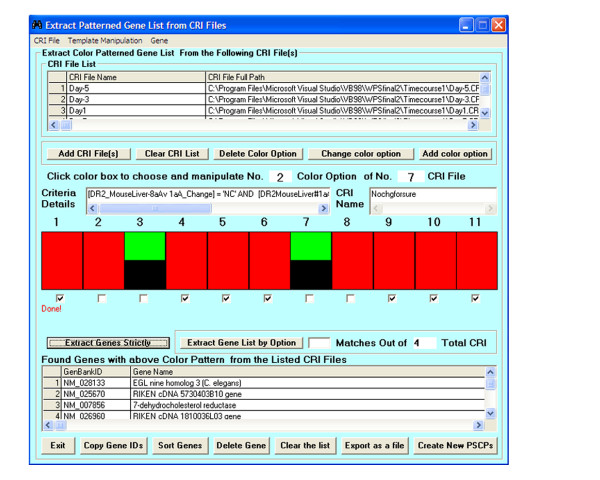
The <Extract Patterned Gene List from CRI Files> window for pattern extraction. CRI files from time course experiments were entered into this window. The template pattern was set as shown in middle of the window. Totally 11 color blocks represented 11 CRI files of time course experiments. The small check boxes under the color blocks are to determine if the corresponding color block or CRI template is ignored If the underneath check box is checked. The multiple color templates were set for No. 3 (Day 1) and No. 7 (Day 18) CRI files as indicated by vertically discrete boxes (green and black boxes). Extracted genes were entered into the table for further processing.